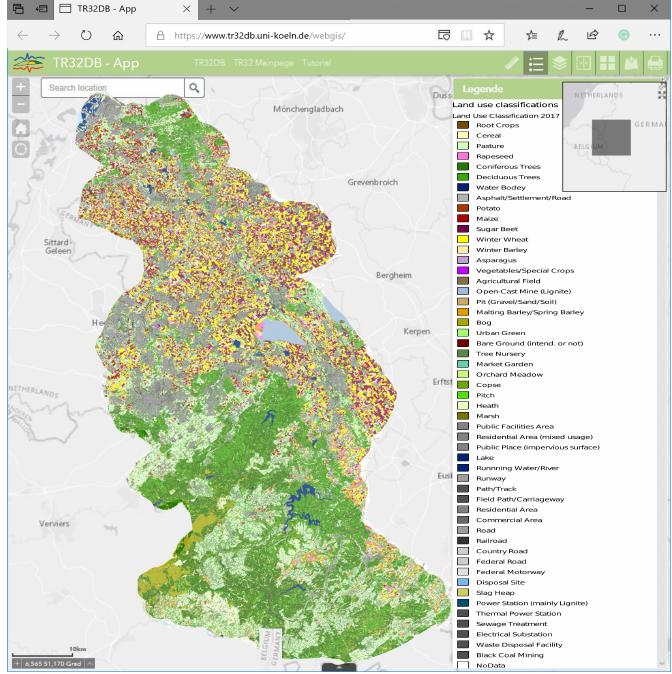
Figure 1. Location of the study region Rur Catchment and land use / land cover (LULC) analysis of 2017 using the Multi Data Approach (MDA) [14] with optical satellite data and external data. Screenshot from the online available WebGIS of the TR32 project database